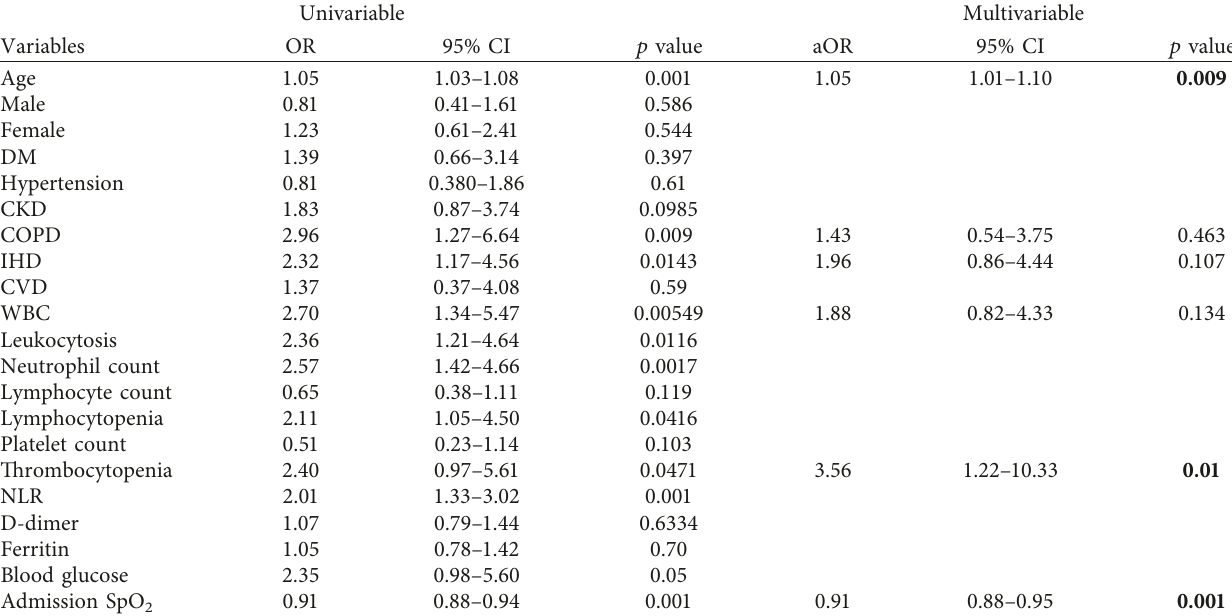
Table 3: Predicting factors for death of the COVID-19 patients: logistic regression analysis.